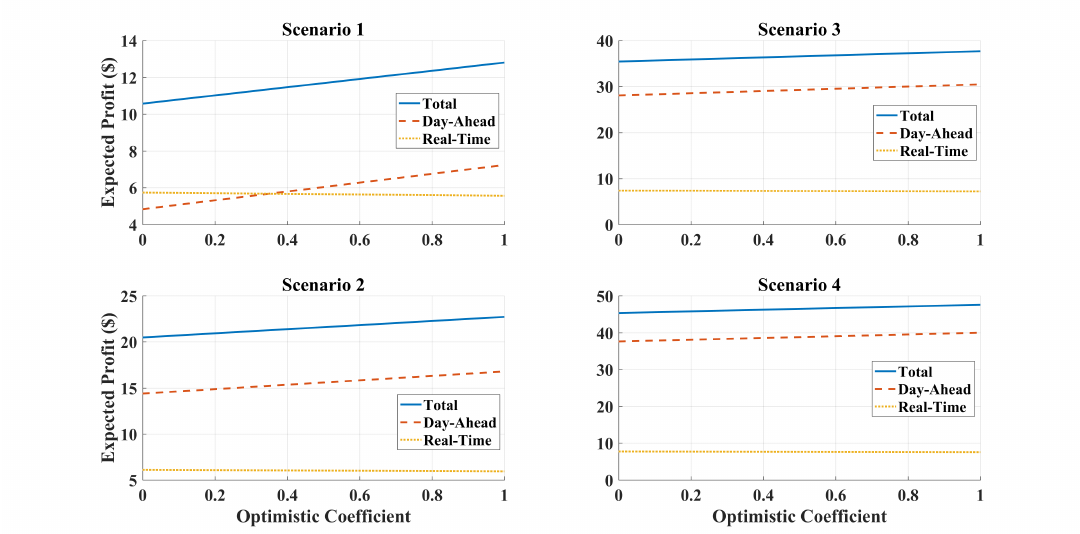
Figure 1. Impact of energy flexibility on the amounts of total, day-ahead and real-time expected